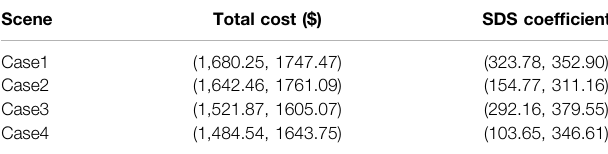
TABLE 2 | Numerical range of optimization results of four